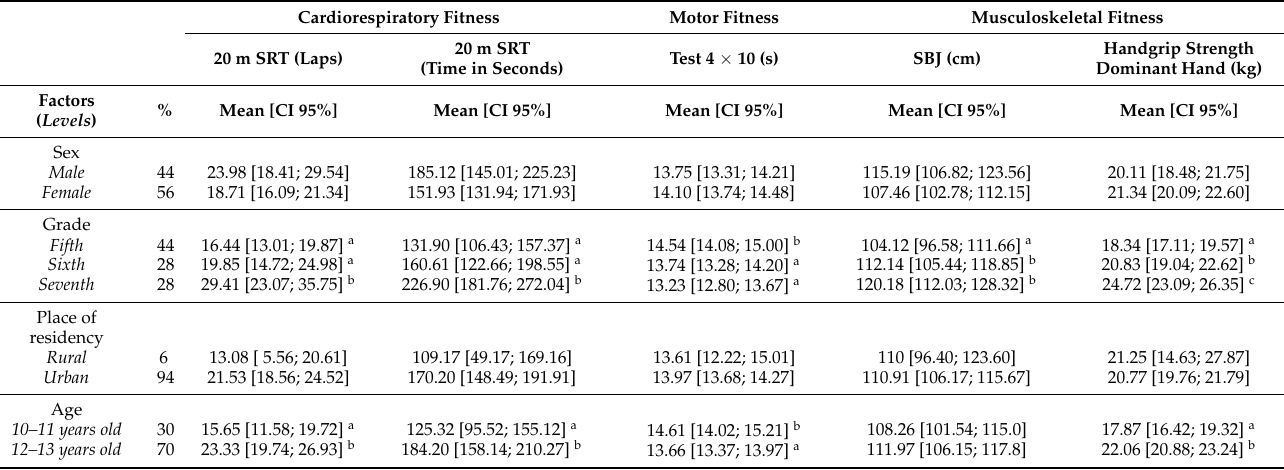
Table 1. Socio-educational characteristics of the sample.